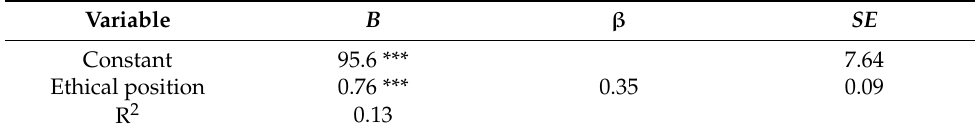
Table 7. Regression coefficient of ethical position on concern for animal welfare (N = 450). Variable B Constant